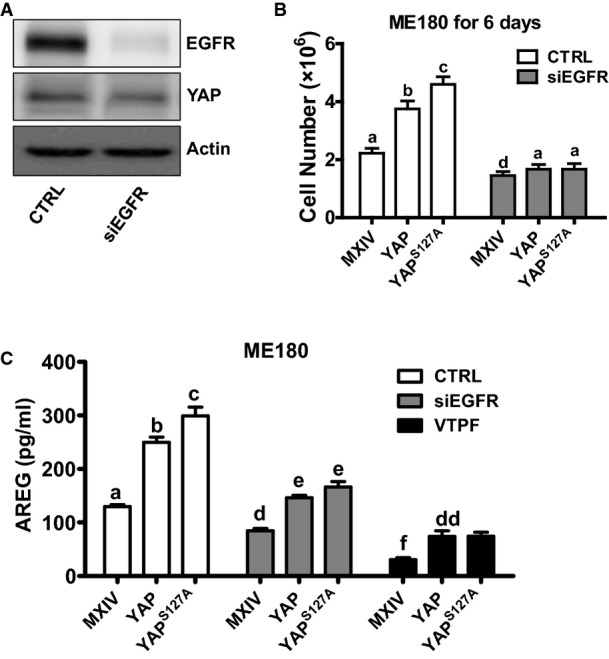
Knockdown of EGFR suppressed YAP-induced cell growth in cancerous cervical cells
Western blot analysis showed that siRNAs of EGFR successfully knocked down EGFR in ME180 cells.

Knockdown of EGFR blocked YAP-induced proliferation of ME180 cells. Each bar represents the mean ± SEM of five independent experimental results. Bars with different letters are significantly different from each other (CTRL-MXIV vs. siEGFR-MXIV, P = 0.0167; CTRL-YAP vs. siEGFR-YAP, P < 0.0001; CTRL-YAPS127A vs. siEGFR-YAPS127A, P < 0.0001).

EGFR knockdown or verteporfin treatment dramatically decreased YAP-induced AREG secretion. Each bar represents the mean ± SEM of five independent experimental results. Bars with different letters are significantly different from each other (CTRL-MXIV vs. siEGFR-MXIV, P = 0.0006; CTRL-MXIV vs. VTPF-MXIV, P < 0.0001; CTRL-YAP vs. siEGFR-YAP, P = 0.0007; CTRL-YAP vs. VTPF-YAP, P < 0.0001; CTRL-YAPS127A vs. siEGFR-YAPS127A, P < 0.0001; CTRL-YAPS127A vs. VTPF-YAPS127A, P < 0.0001).
Data information: Data in (B) and (C) were analyzed for significance using two-way ANOVA in GraphPad Prism 5.